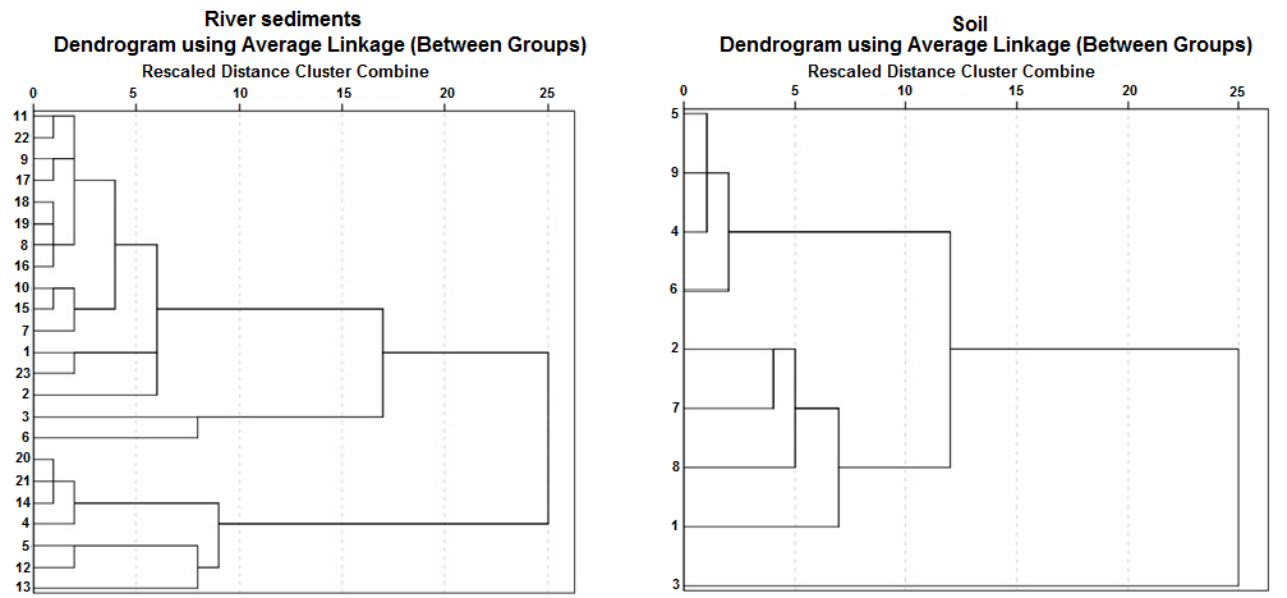
Figure 5. Cluster analyses in Q mode of heavy metals and trace elements in river sediments and soil.